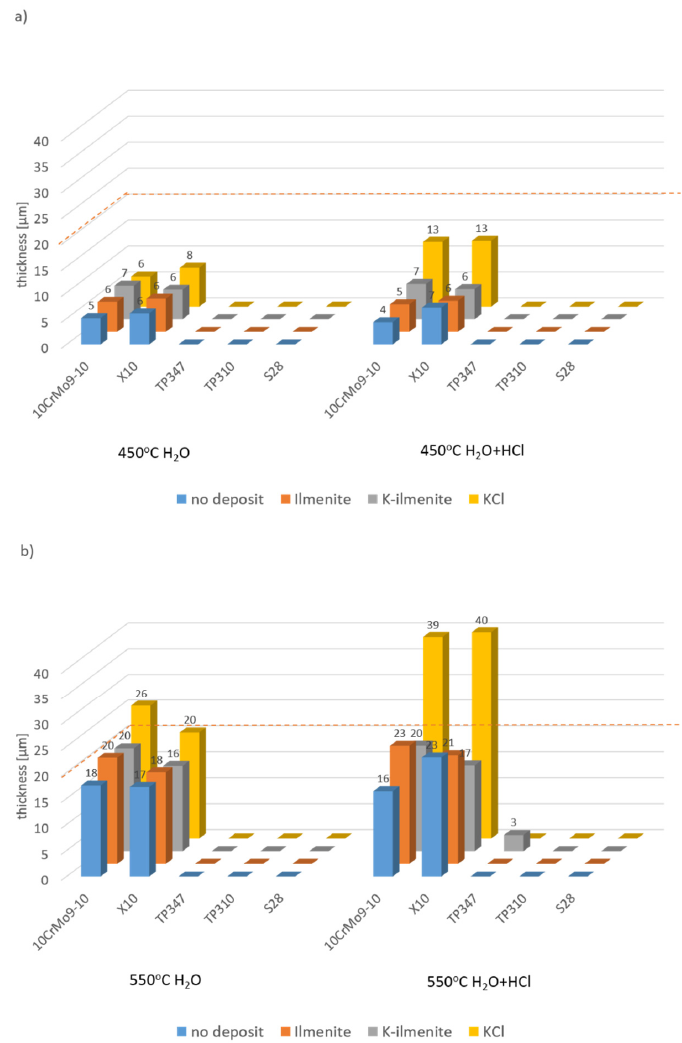
Figure 8. Mean thickness of oxide layers (µm) of samples exposed in ( a ) 50/50 CO 2 /H 2 O and 50/50 CO 2 /H 2 O + 500 ppm HCl at 450 °C and ( b ) 50/50 CO 2 /H 2 O and 50/50 CO 2 /H 2 O + 500 ppm HCl at 550 °C for 168 h. The dotted line indicates the 20 µm line above which corrosion is considered significant.